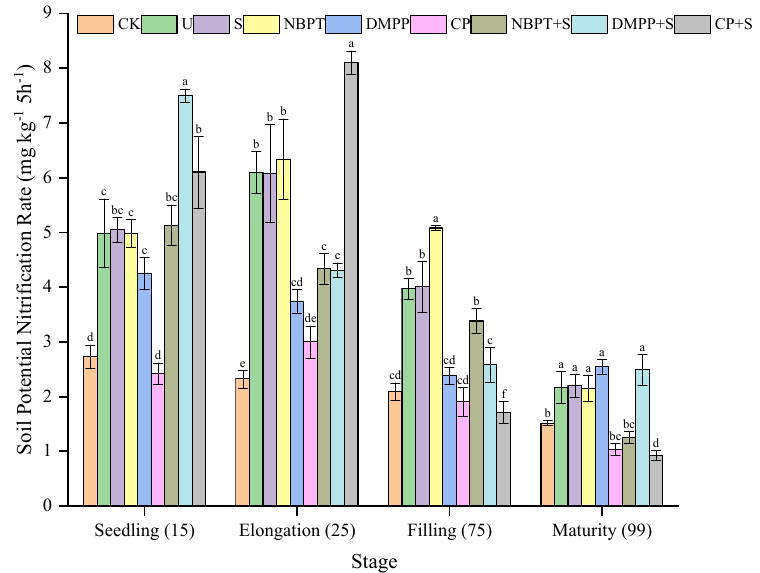
Figure 3. Soil Potential Nitrification Rate (PNR) of different treatments. Different letters indicate significant differences between different treatments at p < 0.05 by Tukey test.